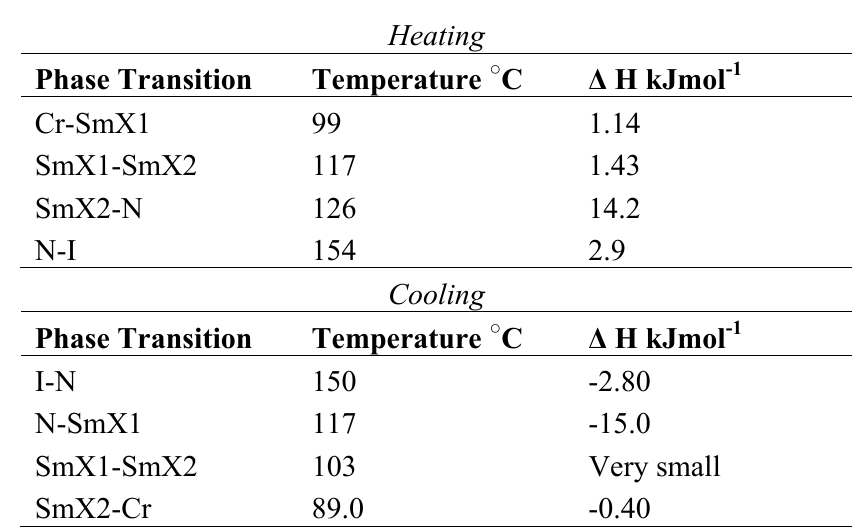
Table 1. Phase transition temperatures and enthalpy changes of compound 2